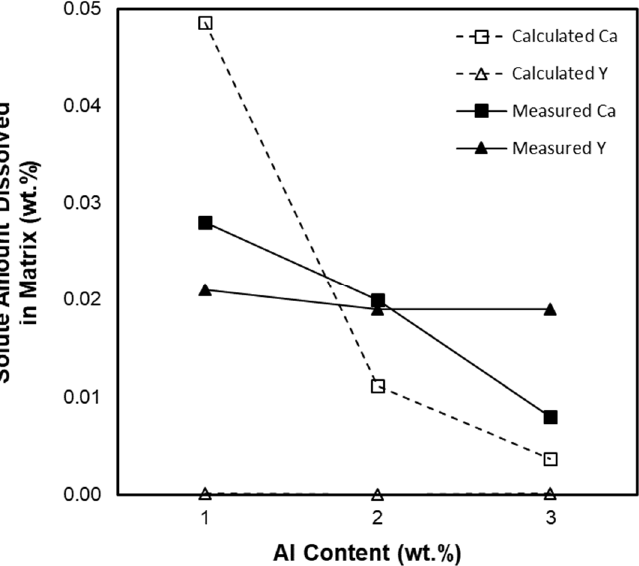
Figure 3. Quantitative analysis of Ca and Y solutes dissolved in matrix grains, with varying Al contents.